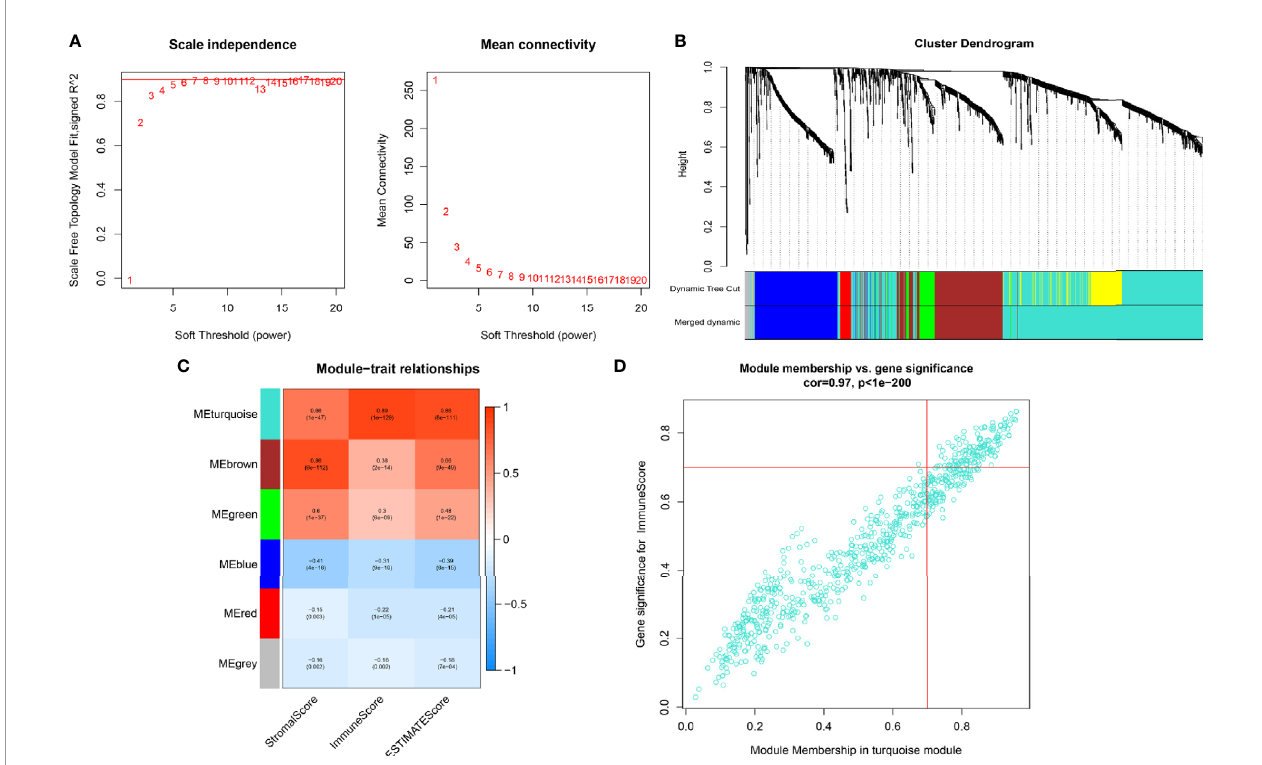
FIGURE 2 | (A) In order to achieve a scale-free co-expression network, we chose power index = 4 as the appropriate soft threshold. (B) Identi fi cation of a gene consensus module. The branches of the dendrogram correspond to four different gene modules. (C) Correlation between the gene modules and tumor microenvironment related scores, including immune score, stromal score, and ESTIMATE score. Each cell contains corresponding correlation coef fi cient and p-value. The correlation coef fi cient decreased in size from red to blue. (D) Scatter plot of module eigengenes in the turquoise module.